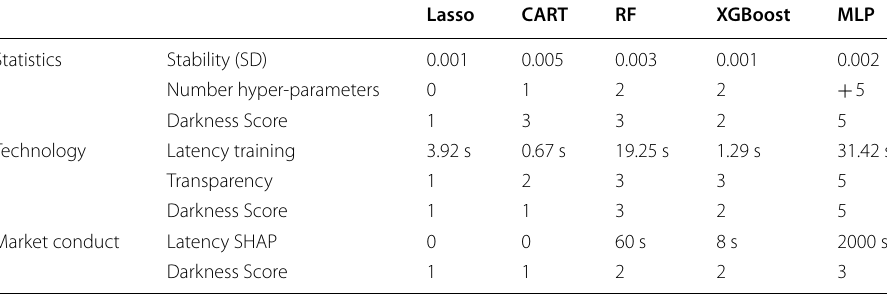
Table 5 Scorecard phase 1: “measuring the darkness of the algorithmic